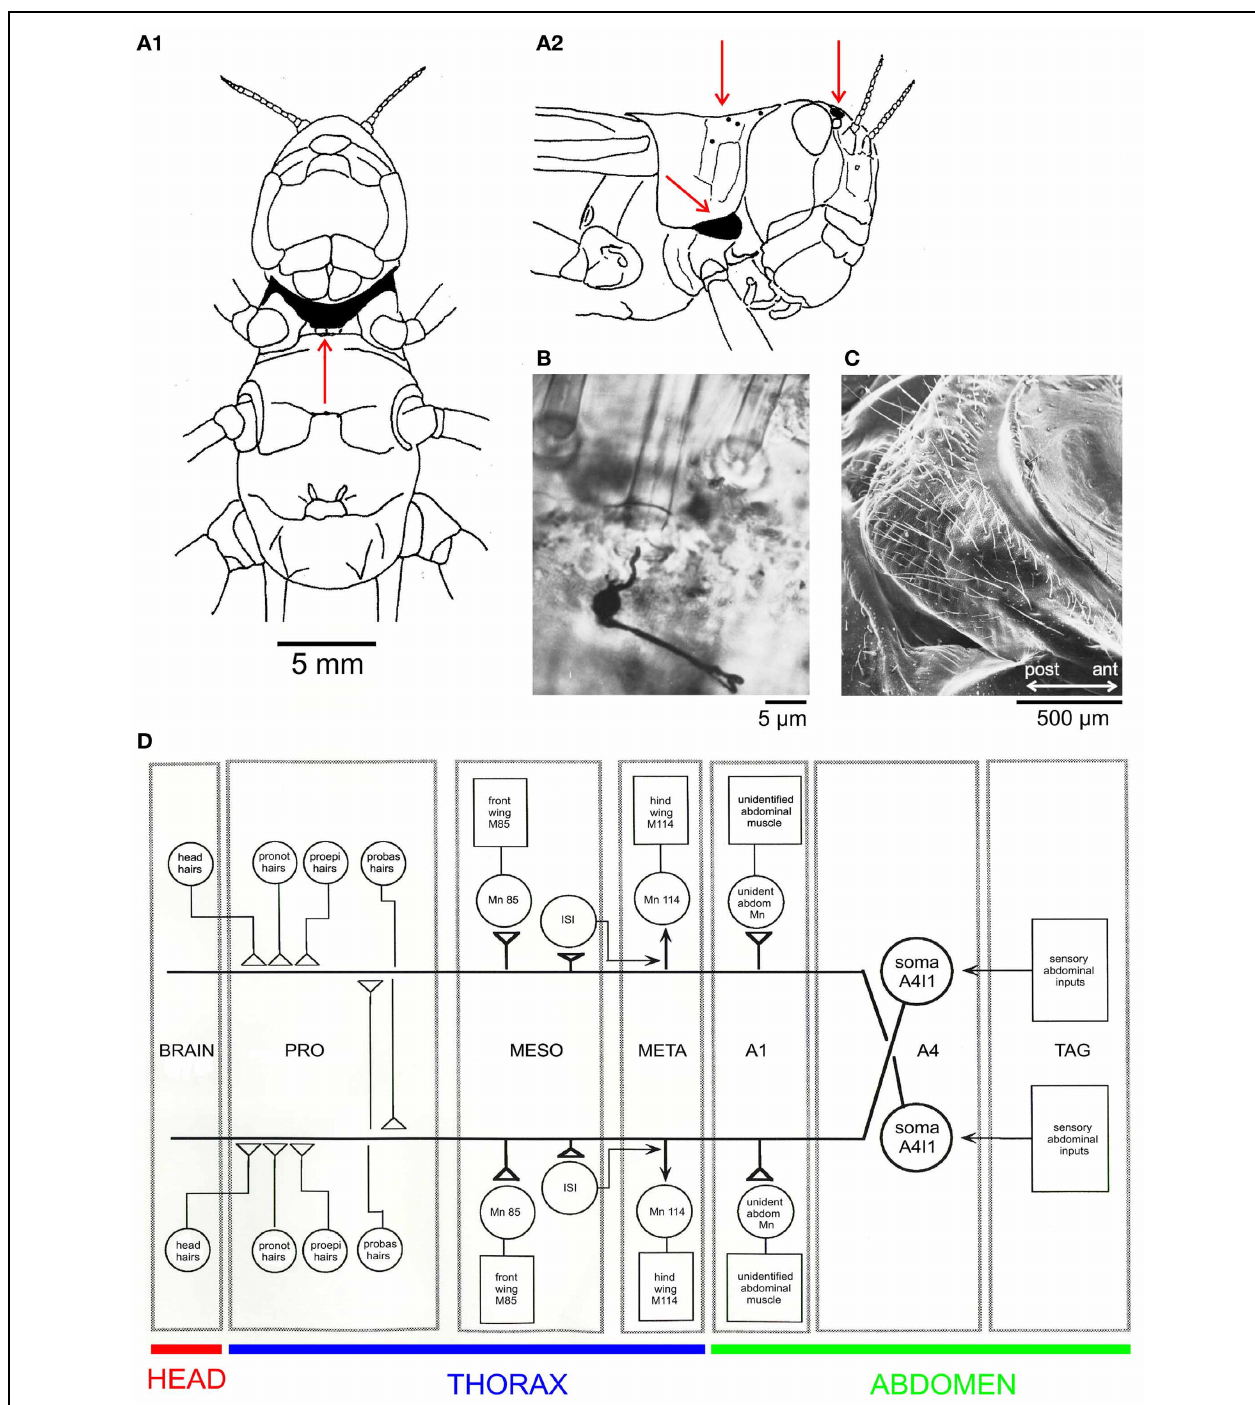
FIGURE 1 | The locust filiform hair-to-interneuron system. (A) Schematic drawings of a locust viewed from the ventral (A1) and lateral (A2) sides; red arrows indicate locations of filiform hairs in the areas shaded in black: the ventral probasisternum (A1) , the lateral proepisternum ( A2 , ventral), the dorsal pronotum ( A2 , dorsal), and field 1 of the wind sensitive head hairs. (B) Silver-intensified cobalt fill of the peripheral sensory nerve revealing cell body and initial axon segment of a mechanoreceptive sensory neuron and its dendrite attached to the base of a filiform probasisternal hair in a